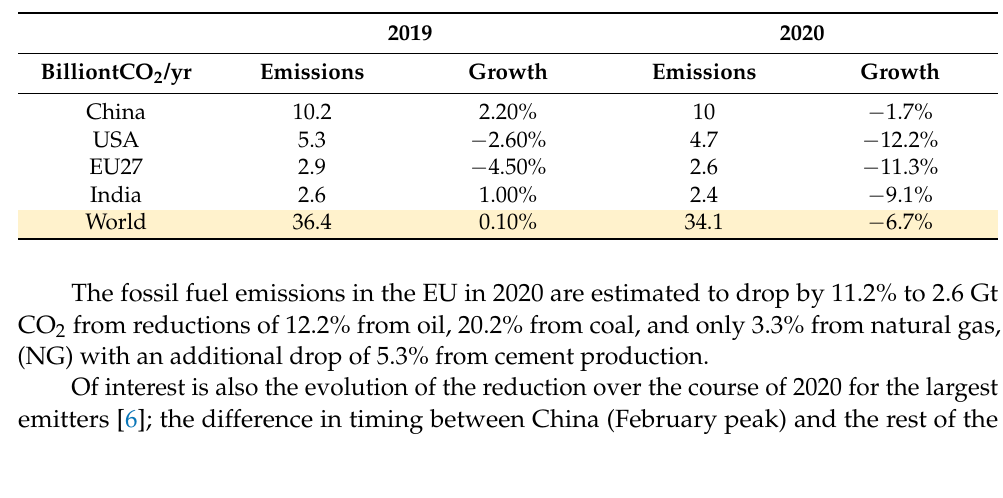
Table 1. Yearly emissions and year-to-year %